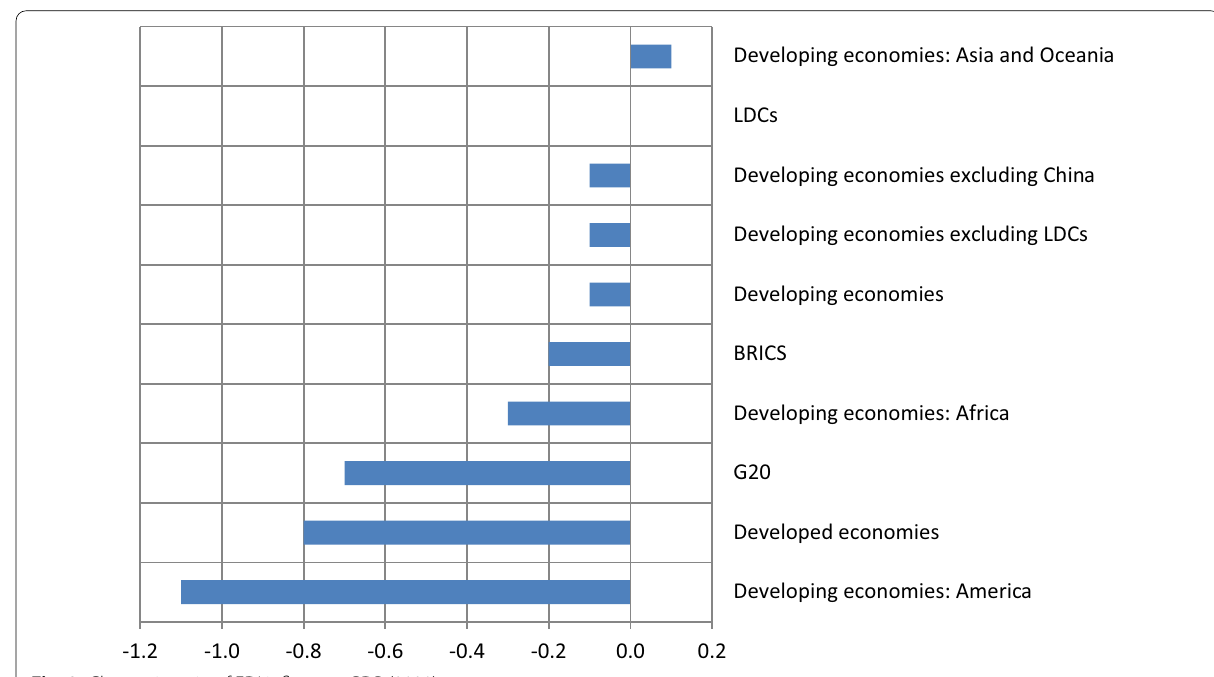
Fig. 3 Change in ratio of FDI inflows to GDP